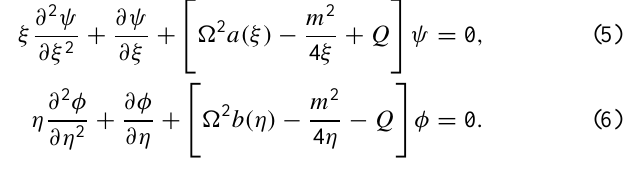
Fig. 4. An orthogonal system of dimensionless parabolic coordi- nates ( ξ,η ) in a cross section containing the z axis. The focus z = 0 is located at the Earth’s centre. The surface ξ =1 coincides with the magnetopause. Semiaxes z = ( 0 , ∞ ) and z = ( 0 , −∞ ) coincide with the coordinate surfaces ξ =0 and η =0,